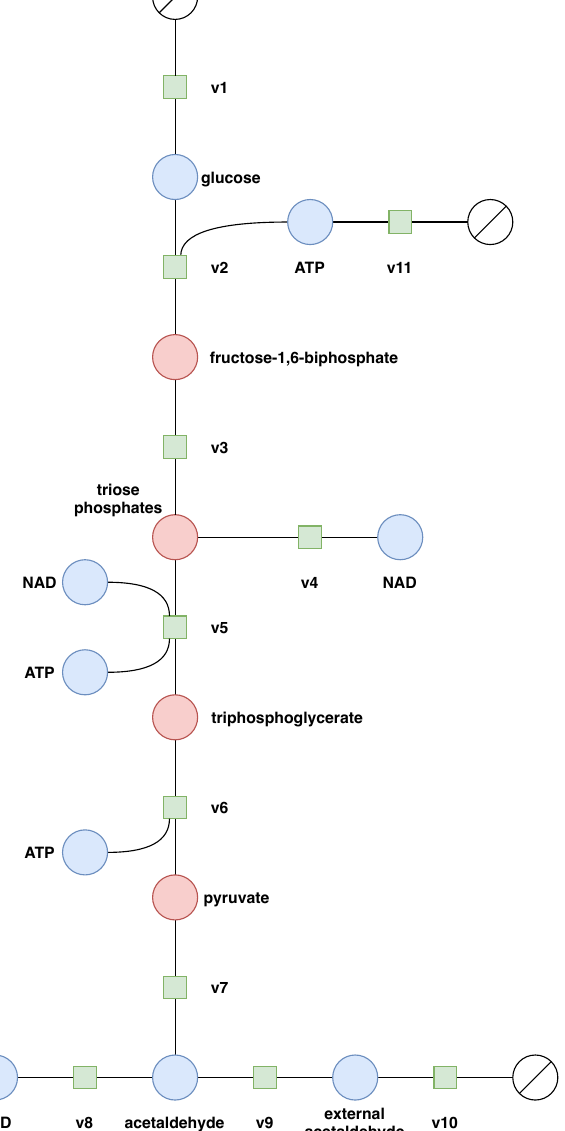
Figure 3. The glycolysis process in the yeast Saccharomyces cerevisiae proposed in [16]. There are 11 reactions governing the process with 18 parameters in total, and 9 metabolites. Blue circles depict observable metabolites, red circles denote unobservable metabolites, and green squares represent reactions. A white circle with a diagonal line corresponds to a sink. The model is taken from the JWS database